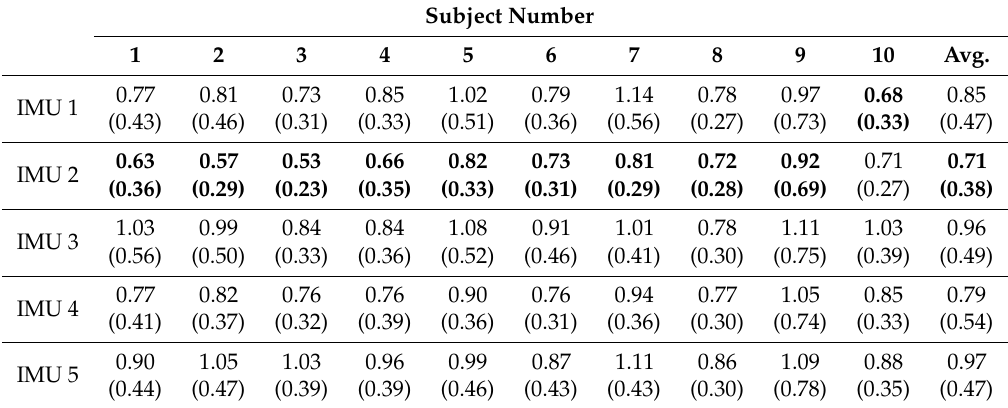
Table 6. Comparison of mean (standard deviation) RMSEs in the cane orientation of the di ff erent IMU sensors on the cane (unit: degrees; estimation method: Madgwick